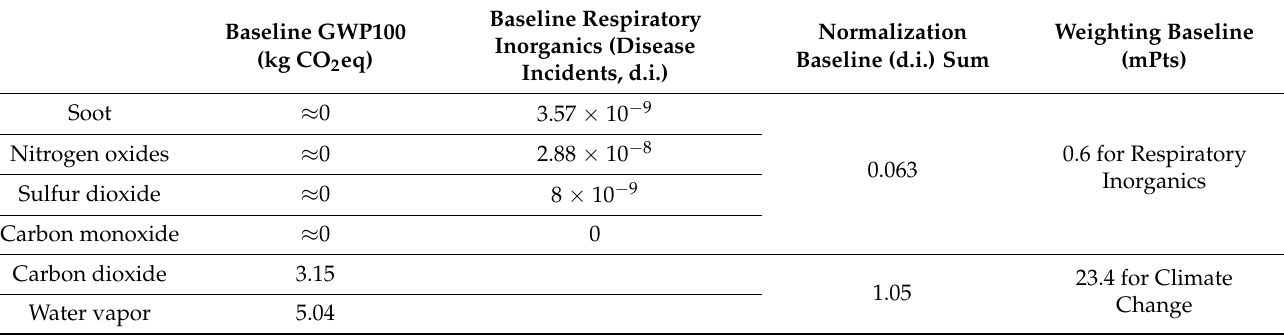
Table 7. Proposed approach EF